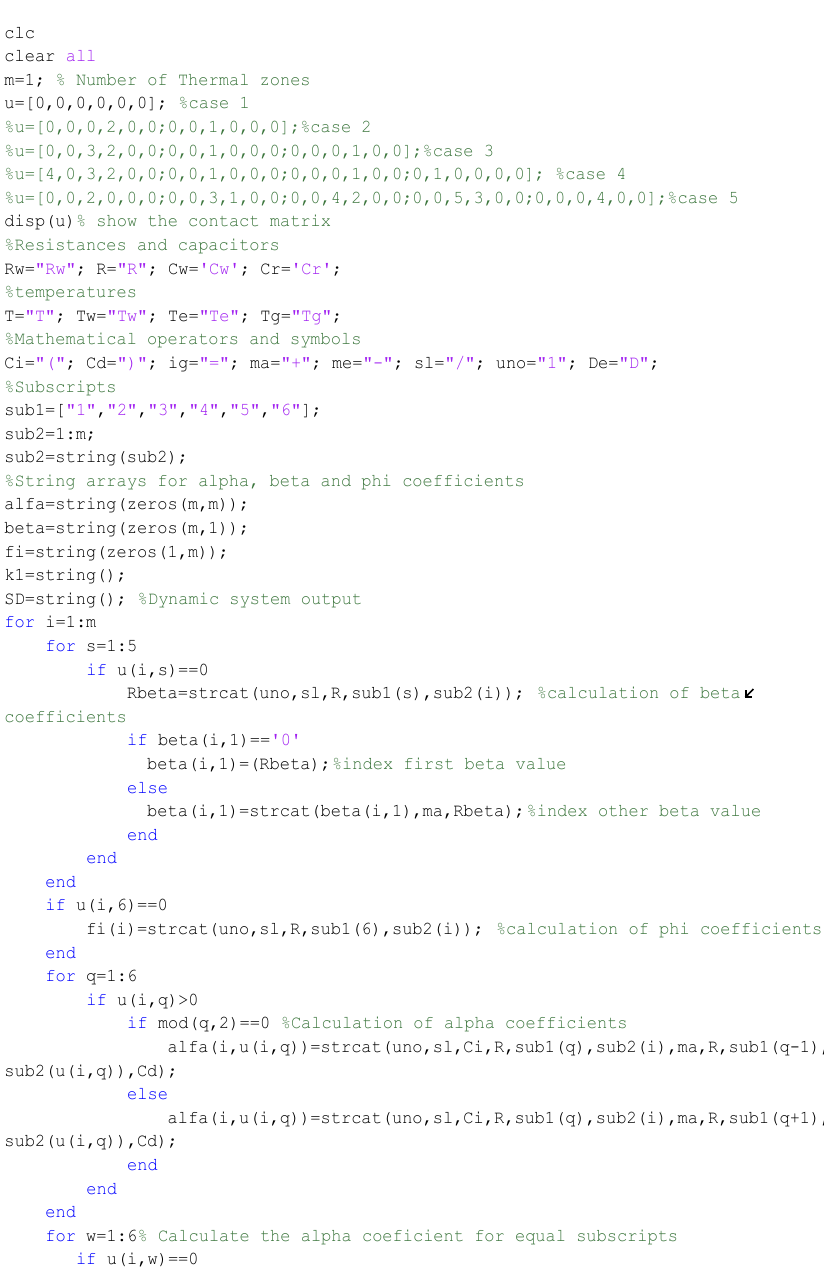
Figure A1. Code to generate mathematical models (part